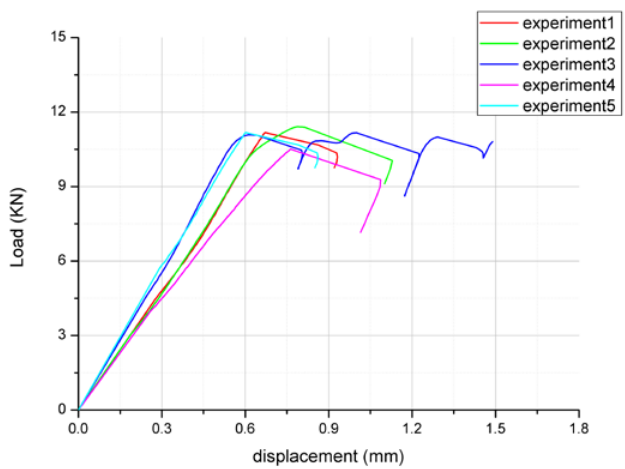
Figure 12. Load-displacement curve of sandwich plate.